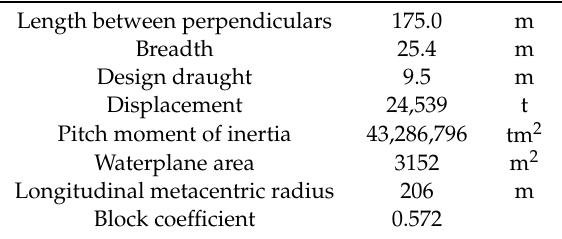
Table 2. Main particulars of the S175 containership.